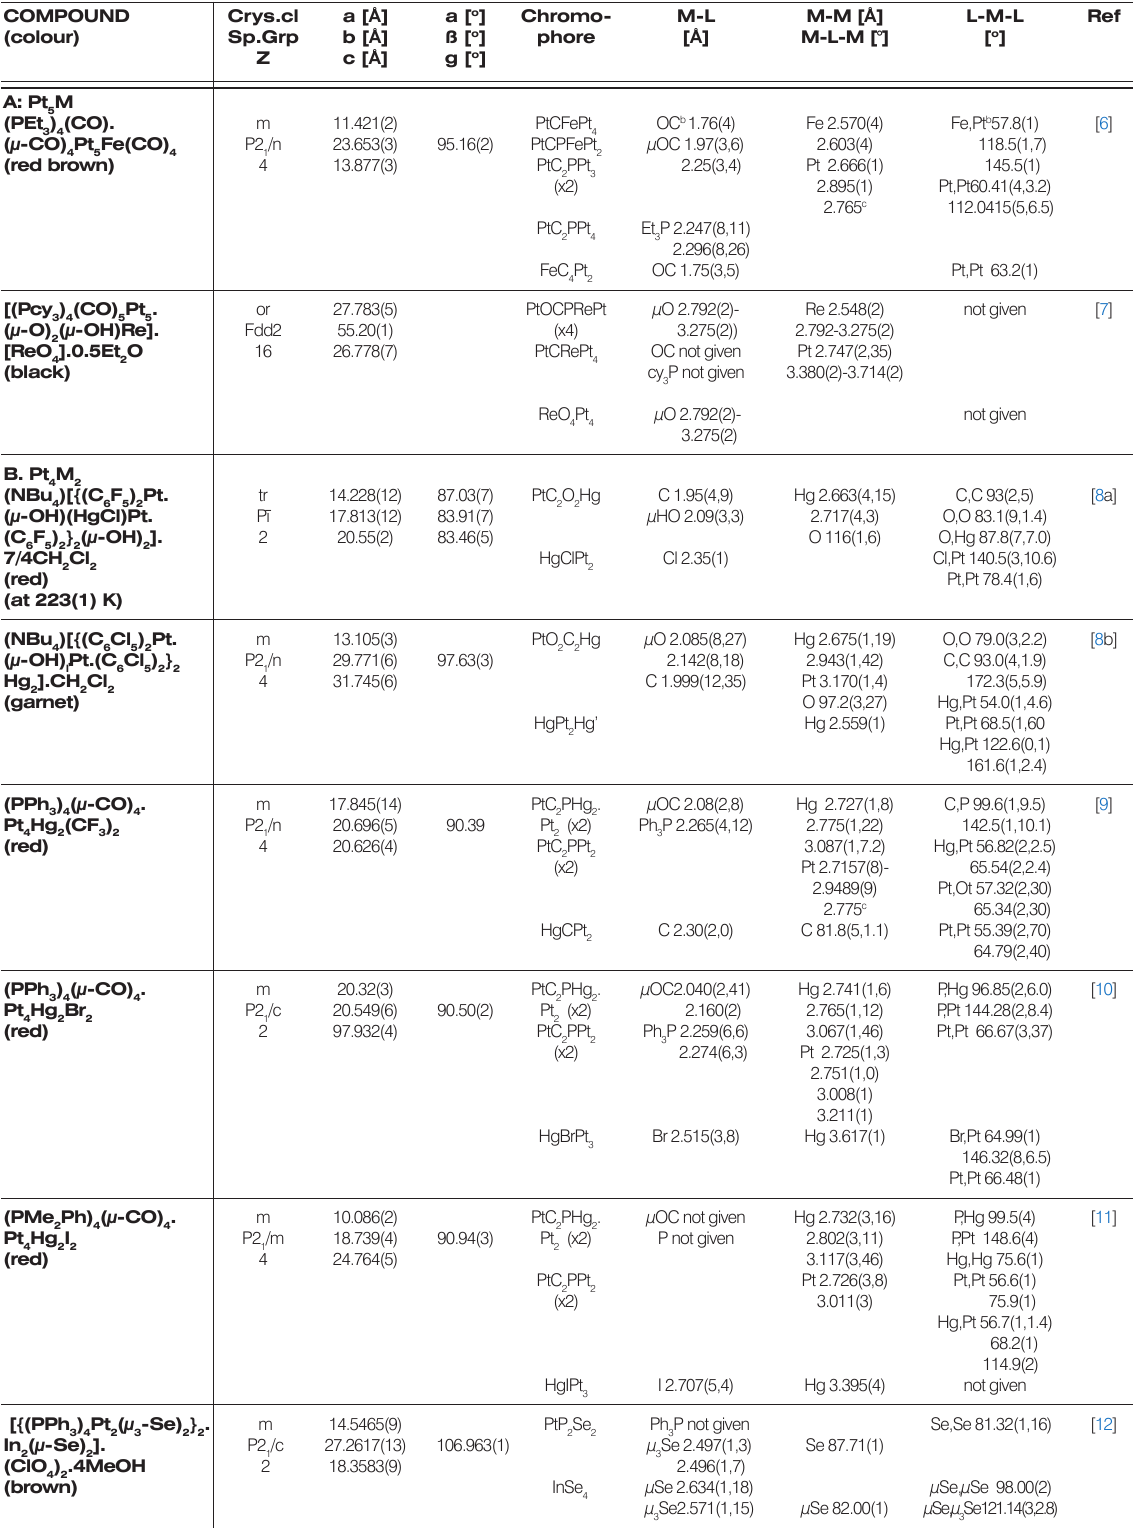
M, Pt M and Pt M ) a . 5 4 2 3 3